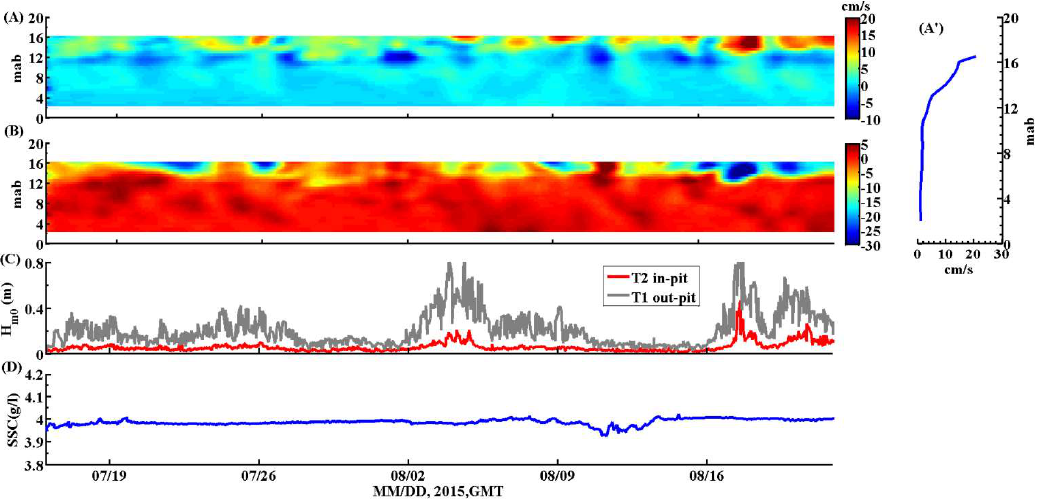
Figure 4. Time series results inside the pit: ( A ) low pass filtered east (+)/west (−) velocities’ vertical structure; mab is meter above bed; ( B ) Low pass filtered north (+)/south (−) velocities’ vertical structure; ( A’ ) vertical structure of low pass filtered mean horizontal current speed; ( C ) Zero moment wave height at T2 (red) and T1 (grey); ( D ) near-bed suspended sediments concentration, calibrated from turbidity counts data.